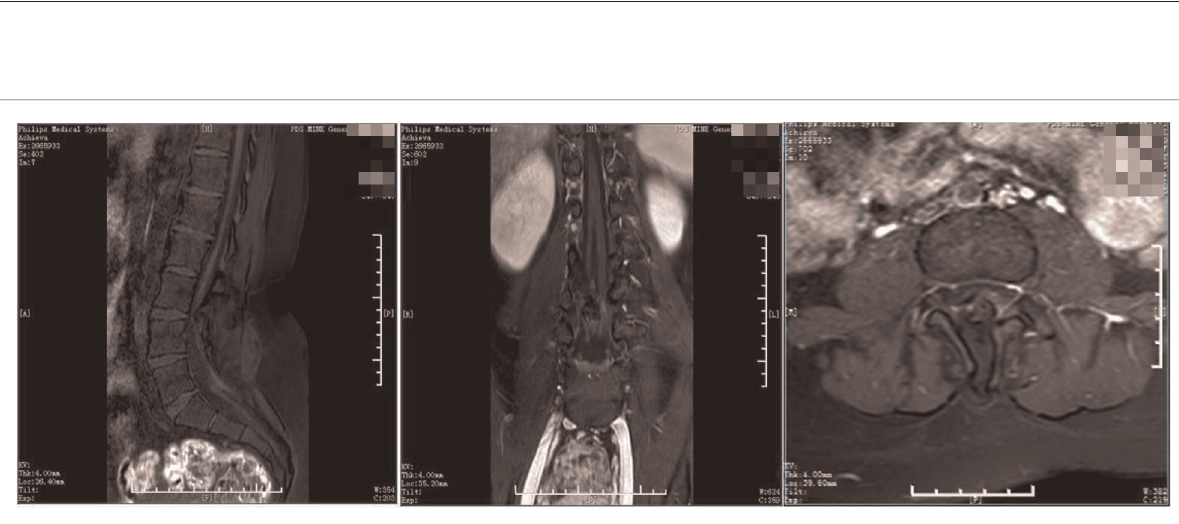
FIGURE 4 Preoperative CT. The lamina of the L3-5 vertebra were not fused, the spinous process of the L3 protrudes inward, considerating diastematorrhachia.